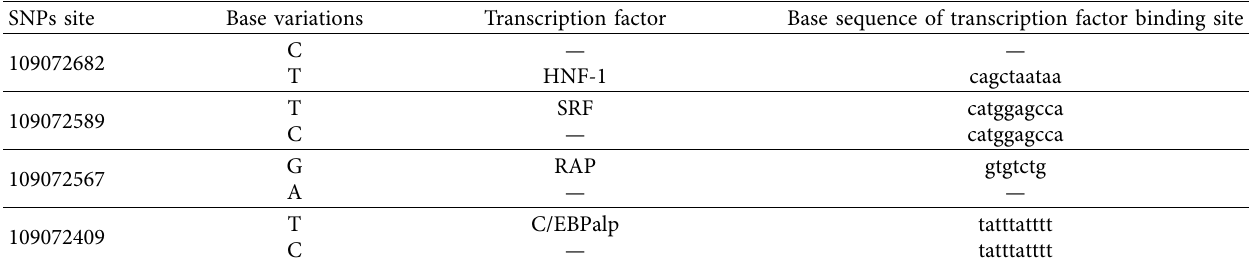
Table 2: Variations in transcription factors before and after a SNP in the TNP1 promoter region. SNPs